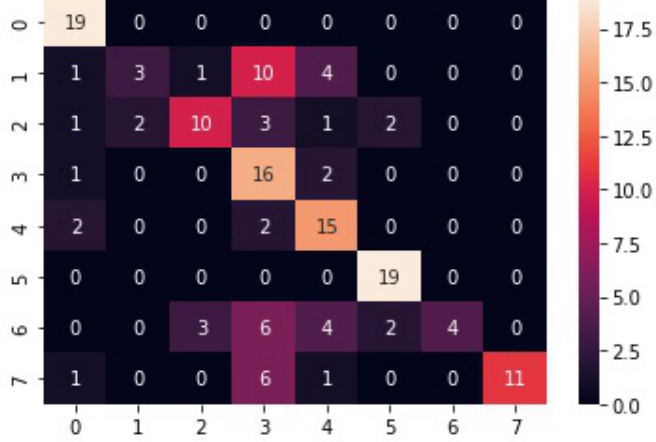
Figure 17. Gaussian-naive-Bayes-based confusion matrix.